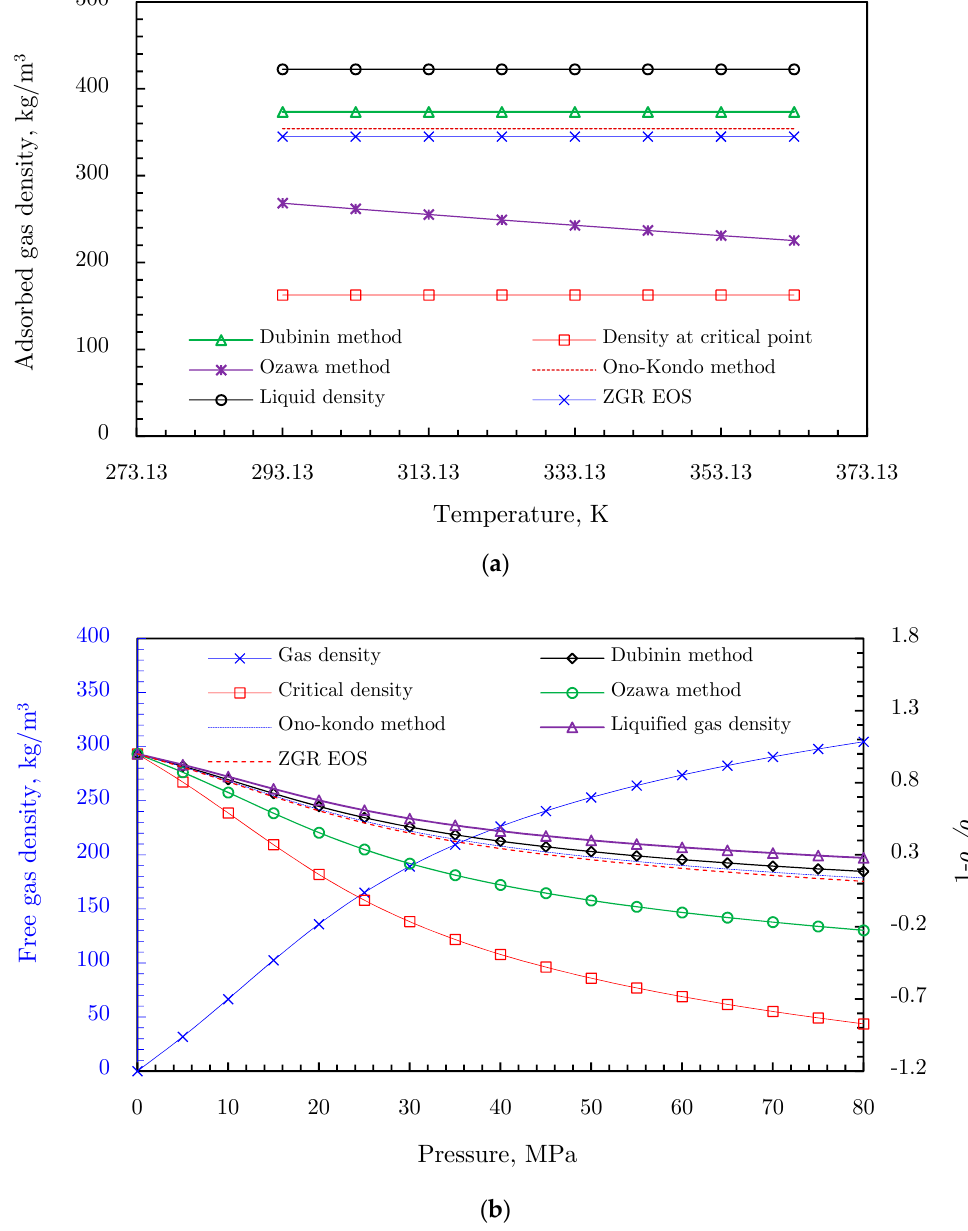
Figure 33. Comparison of adsorbed gas density calculated from different models ( a ) and the change of (1 − ρ g / ρ a ) with increasing pressure ( b ).